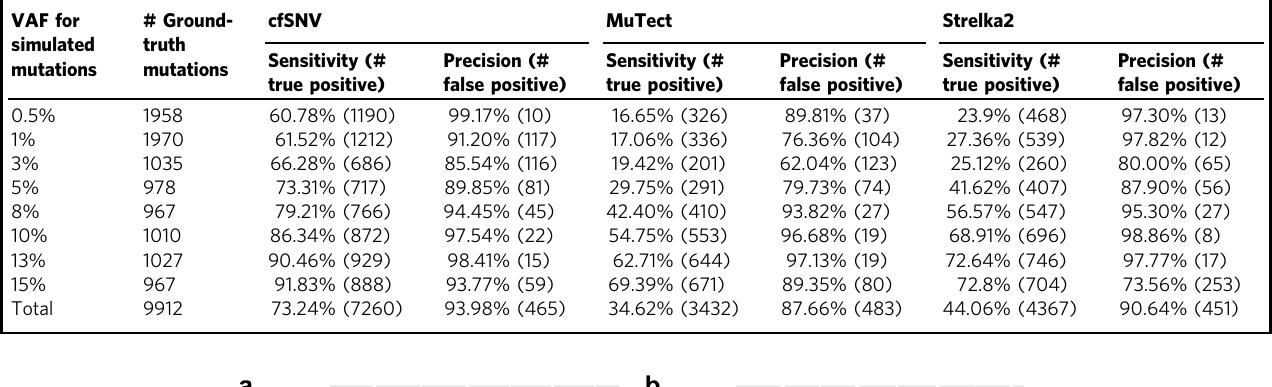
Table 2 Sensitivity and precision of cfSNV for mutations with different VAFs on simulation data. VAF for simulated mutations